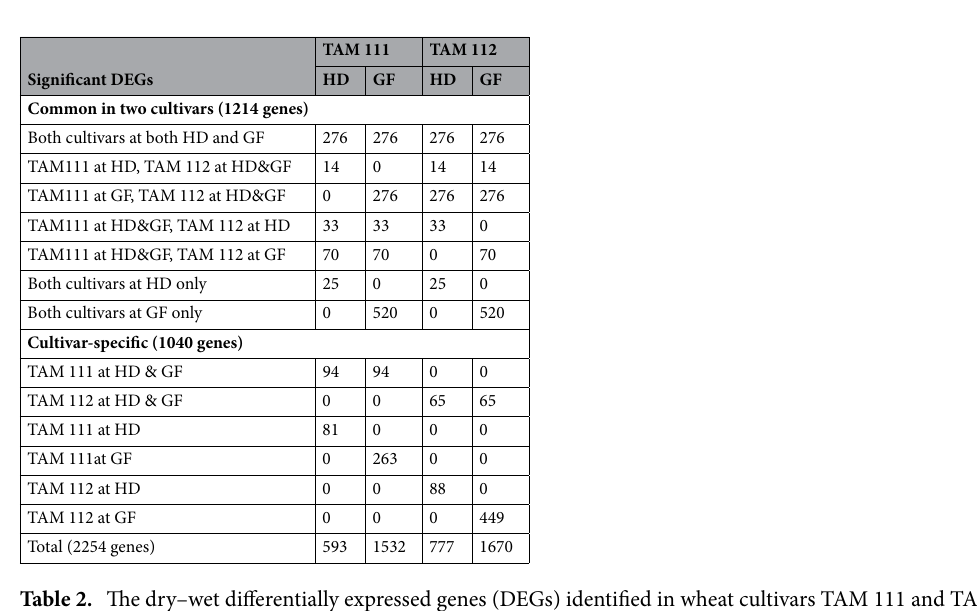
Table 2. The dry–wet differentially expressed genes (DEGs) identified in wheat cultivars TAM 111 and TAM 112 at heading (HD) and grain filling (GF) stages.